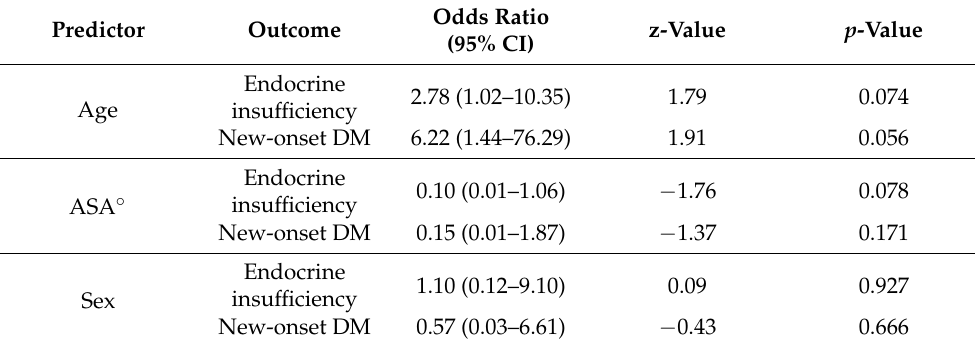
Table A6. Effects of patient characteristics in selected models. Predictor